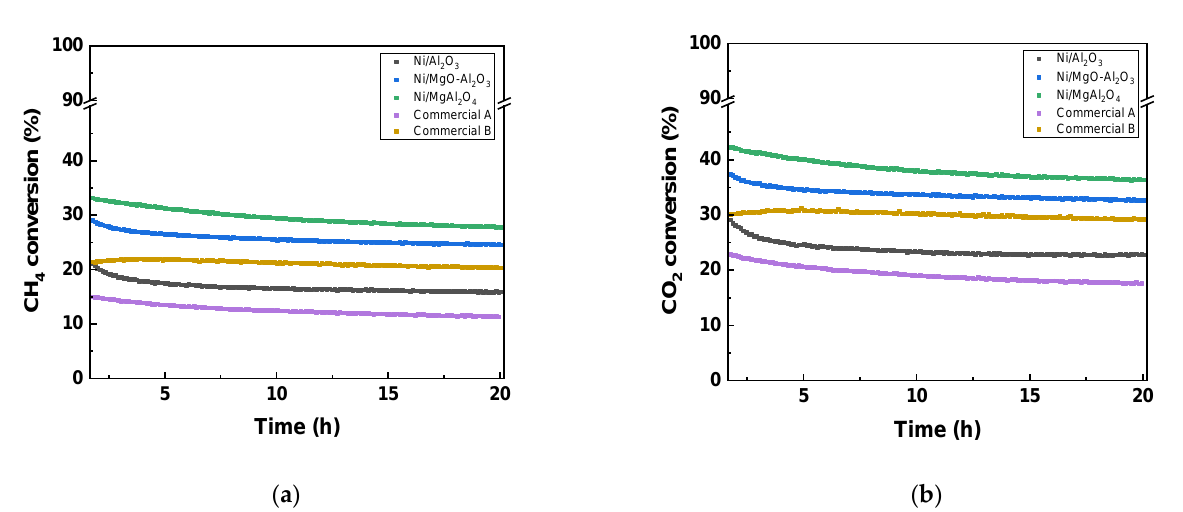
Figure 5. CH 4 conversion ( a ) and CO 2 conversion ( b ) with long-term test over Ni catalysts (reaction conditions: Temp. = 600 °C, CH 4 /CO 2 /N 2 = 1/1/1, GHSV = 144,000 mL/g cat ∙h, TOS = 20 h).